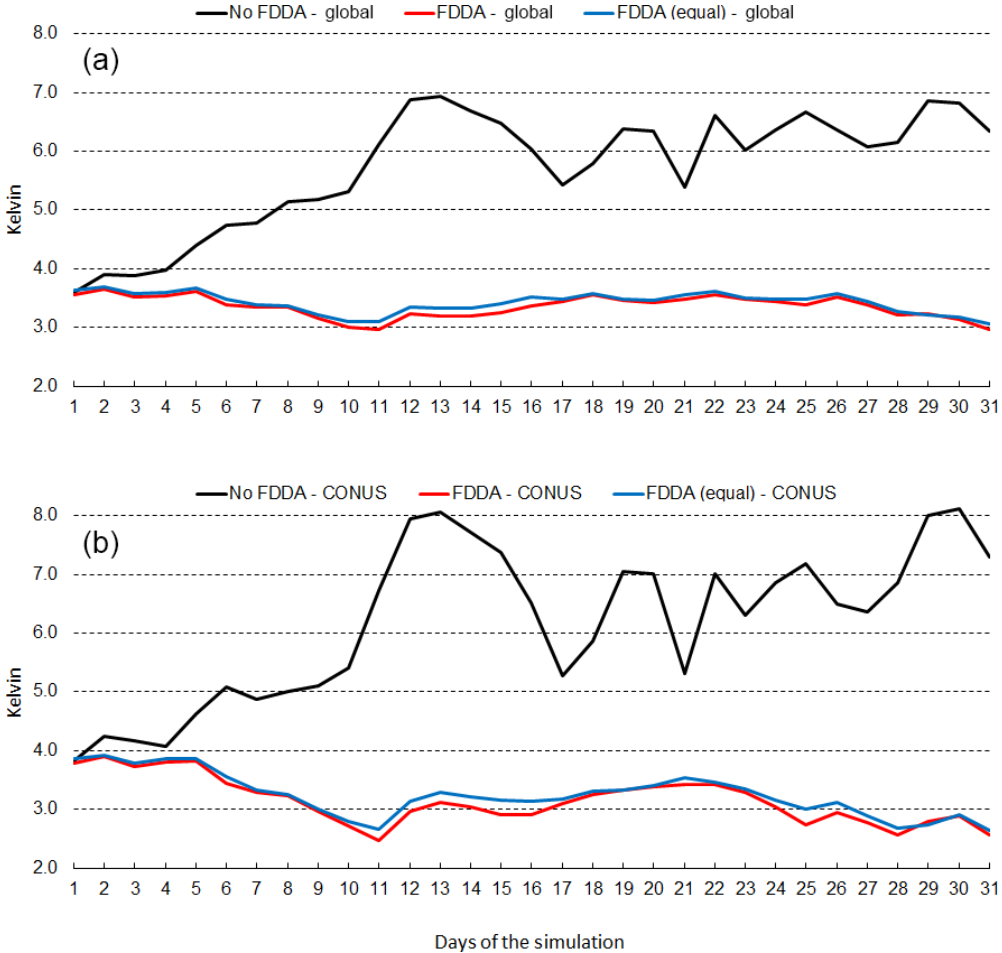
Figure 12. January 2013 time series plots of 2m temperature root mean squared error (RMSE) for MPAS-A without FDDA (black line), MPAS-A with FDDA applied using weaker q v nudging (red line), and MPAS-A with FDDA applied at equal strength for all variables (blue line). Panel (a) shows results for the entire global domain, while (b) shows results for the CONUS